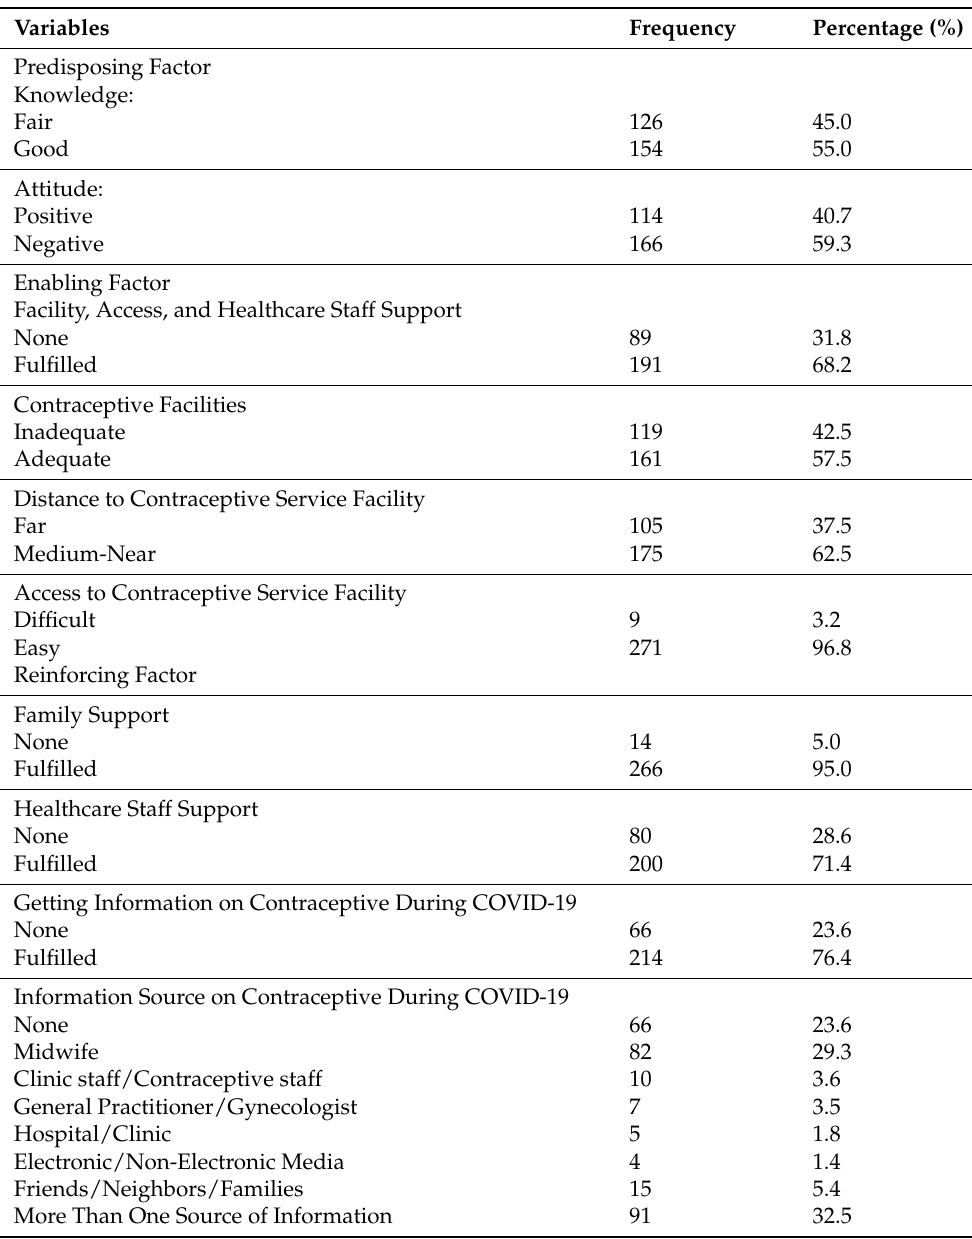
Table 2. Distribution of predisposing factors, enabling factors, and reinforcing factors on post-partum contraception (n =